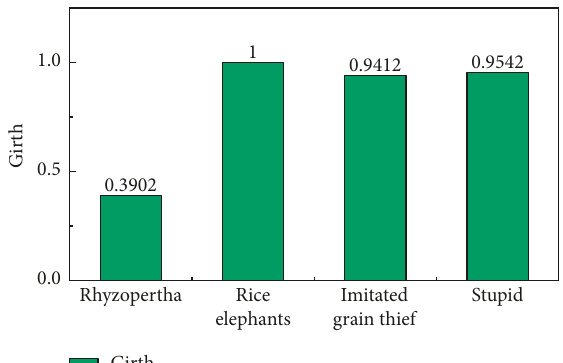
Figure 3: Normalized eigenvalue (perimeter) of identified pests.